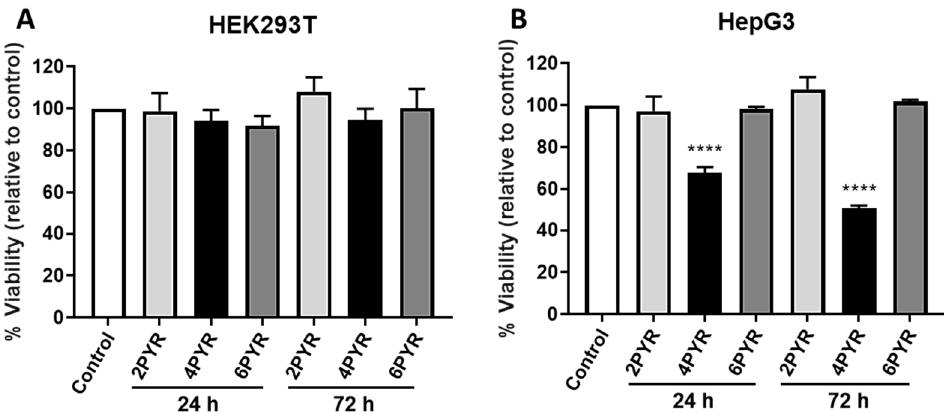
Figure 4. 4PYR is cytotoxic to HepG3 cells but not HEK293T. Cell viability after 72 h was assessed for HEK293T ( A ) and HepG3 ( B ) cells. Cells were exposed to 100 µ M of 2PYR, 4PYR, or 6PYR for 24 h with pyridones removed and fresh medium replaced for an additional 48 h or continuously exposed to the pyridone isomers for 72 h. After 72 h, CellTiter-Fluor TM viability assay was performed with results expressed as the mean fluorescence intensity relative to control, vehicle-treated cells (% Viability) ± standard error of the mean (SEM). Statistical significance: **** p < 0.0001.